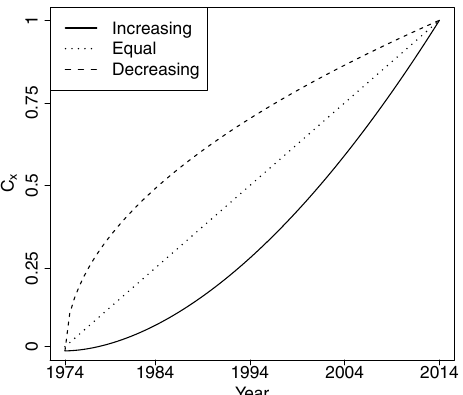
Figure 3. Schematic example of the evolution of the relative cumu- lative sum of monthly drought occurrence ( C x ) for three cases: in- creasing number of drought months towards the end of record (solid line), a constant distribution of drought months over the period of record (dotted line) and decreasing number drought months towards the end of record (dashed